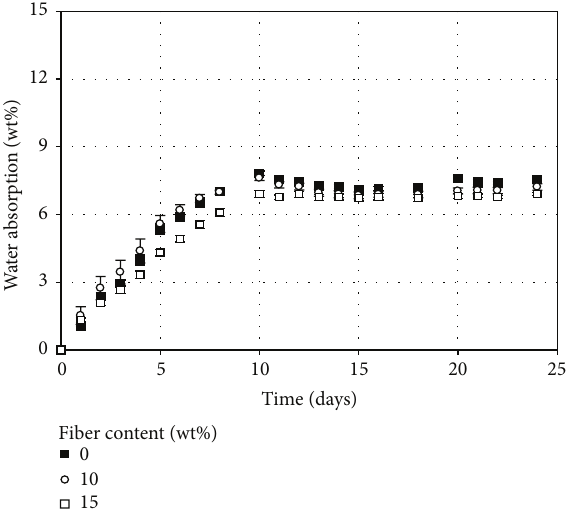
Figure 2: Equilibrium moisture of polymer blends and composites varying PLA content.